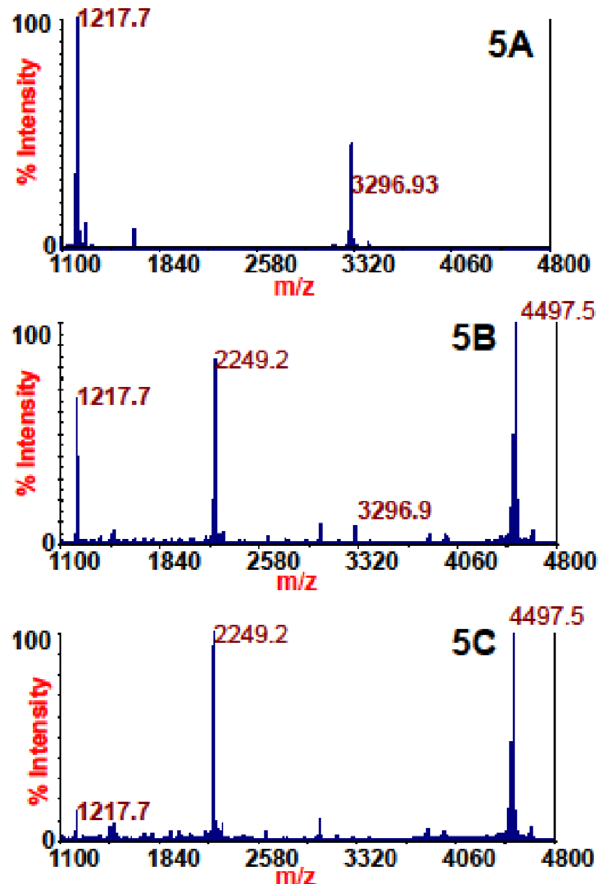
Figure 5. Mass spectra of the Endopep-MS BoNT/D reactions with no antibody extraction (5A), extraction with monoclonal antibody 4E17.1 (5B), or extraction with monoclonal antibody CR2 (5C). The peptide cleavage products indicating BoNT/D are m/z 1217.7 and 3296.9 and the peptide substrate is present at m/z 4497.5.